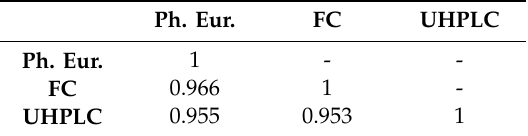
Table 1. Pearson correlations of the reference analyses.